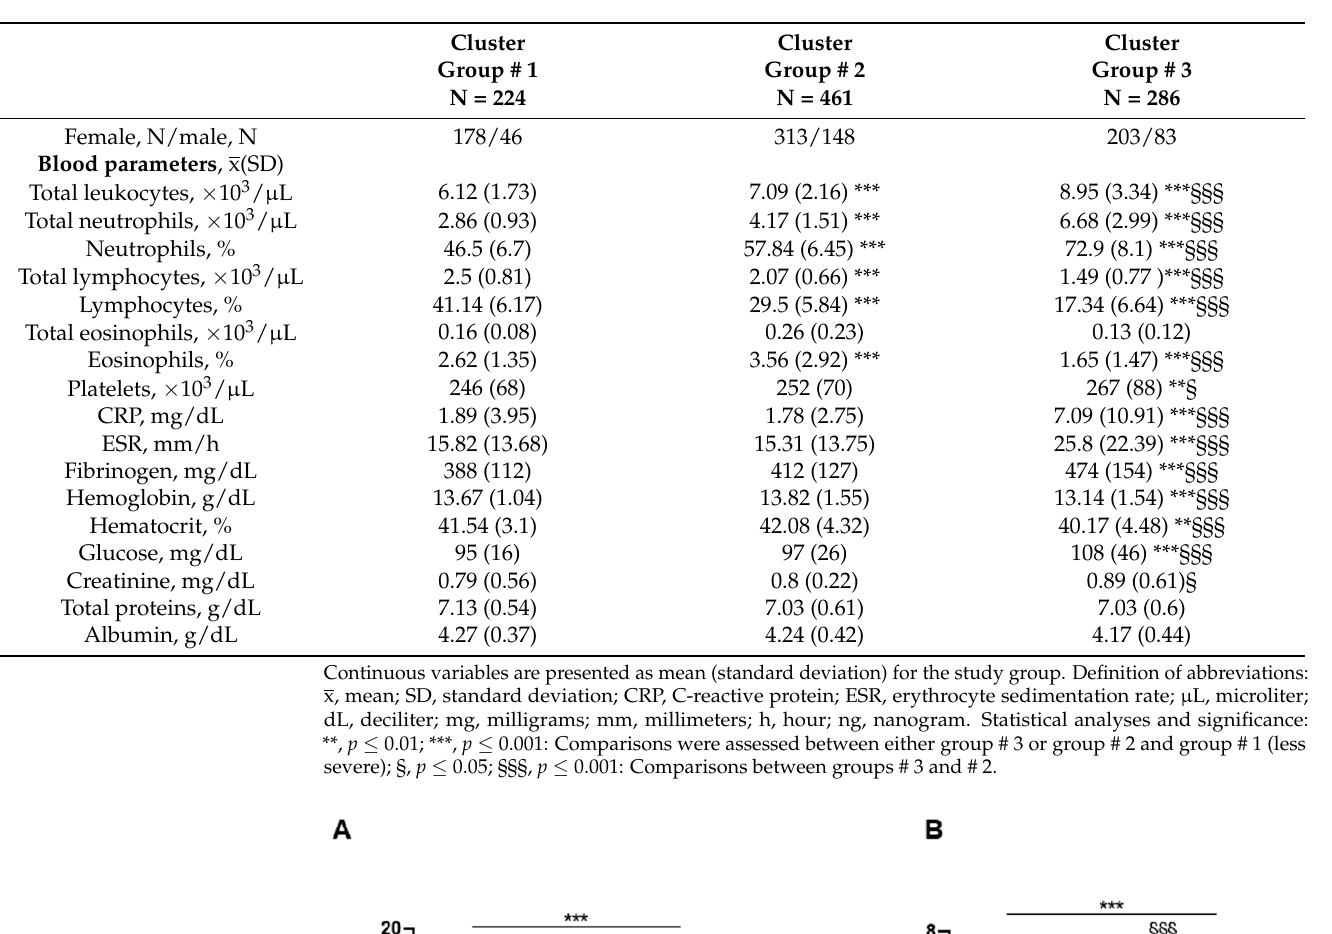
Table 5. Systemic inflammatory and nutritional parameters in the three clusters of patients excluding those with COPD.